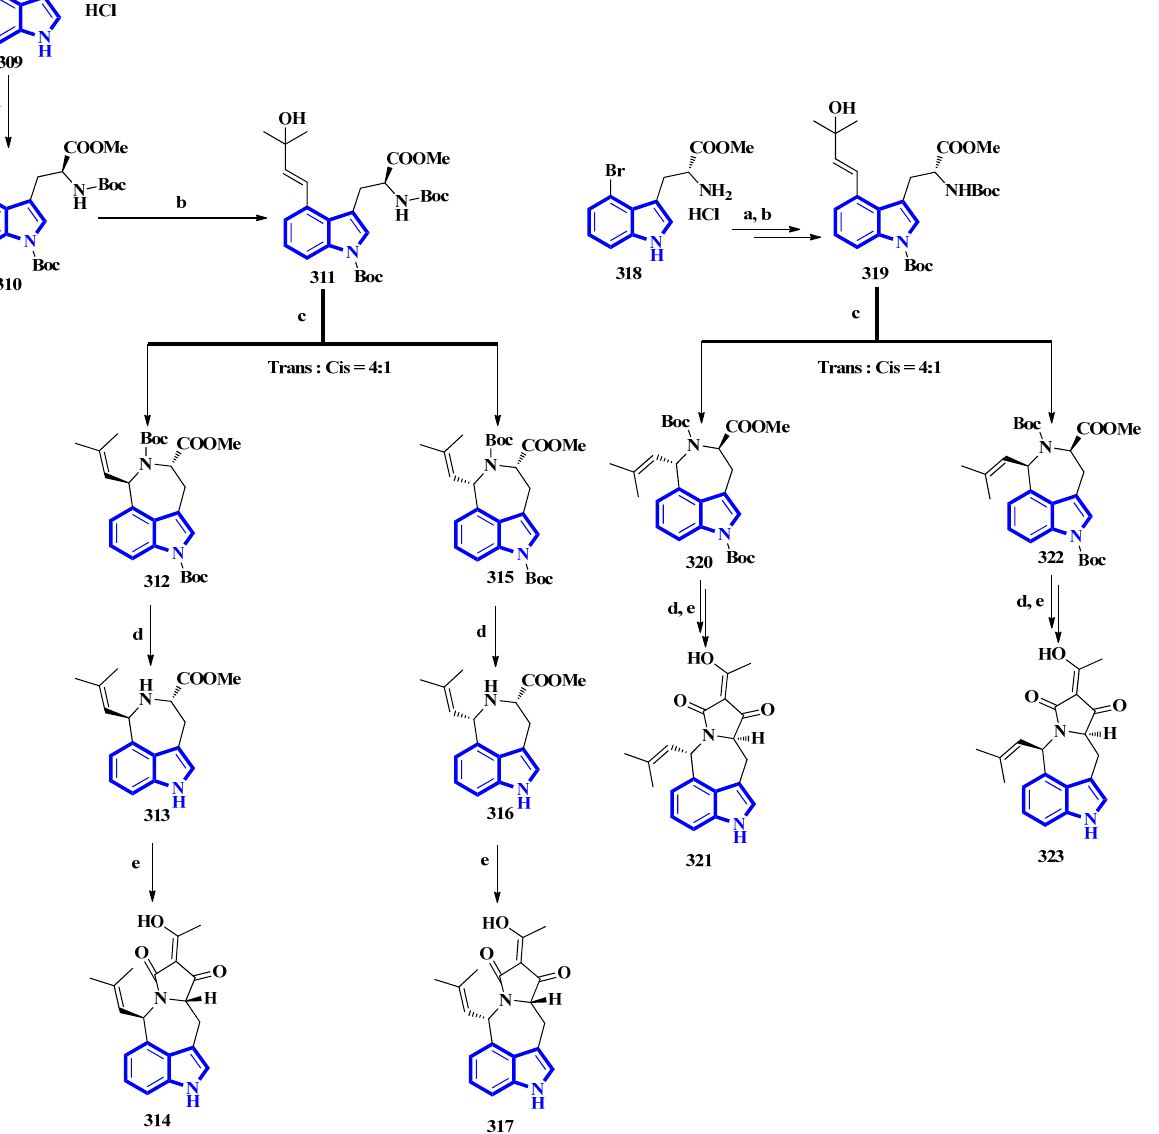
Figure 20. The total synthesis of griseofamine B ( 314 ) and its isomers 317 , 321 , and 323 . (a) Boc 2 O, Et 3 N, DMAP, DCM, reflux, 2 h, 90%; (b) 2-methyl-3-buten-2-ol, PdCl 2 (PPh 3 ) 4 , Ag 2 CO 3 , Et 3 N, 1,4- dioxane, 100 °C, 6 h; 67% (c) PdCl 2 (CH 3 CN) 2 , CH 3 CN, reflux, 2 h; E:Z = 56–58%:15–16% (d) TMSOTf, 2,6-lutidine, DCM, rt, overnight, 87–88%; (e) diketene, Et 3 N, DCM, rt, overnight, 62–63%.